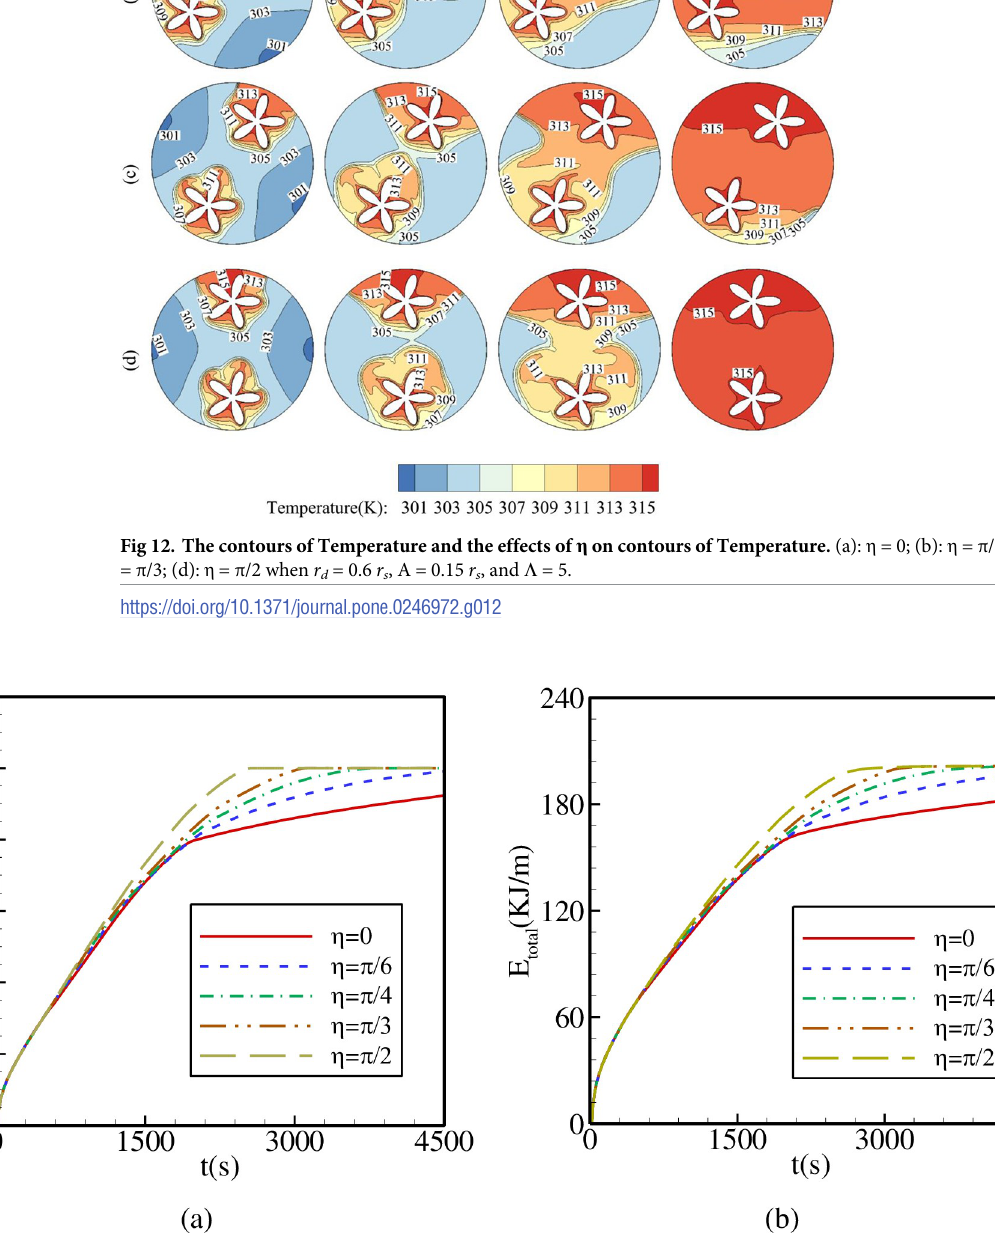
= 0.6 r , A = 0.15 r , and Λ = 5. d s s